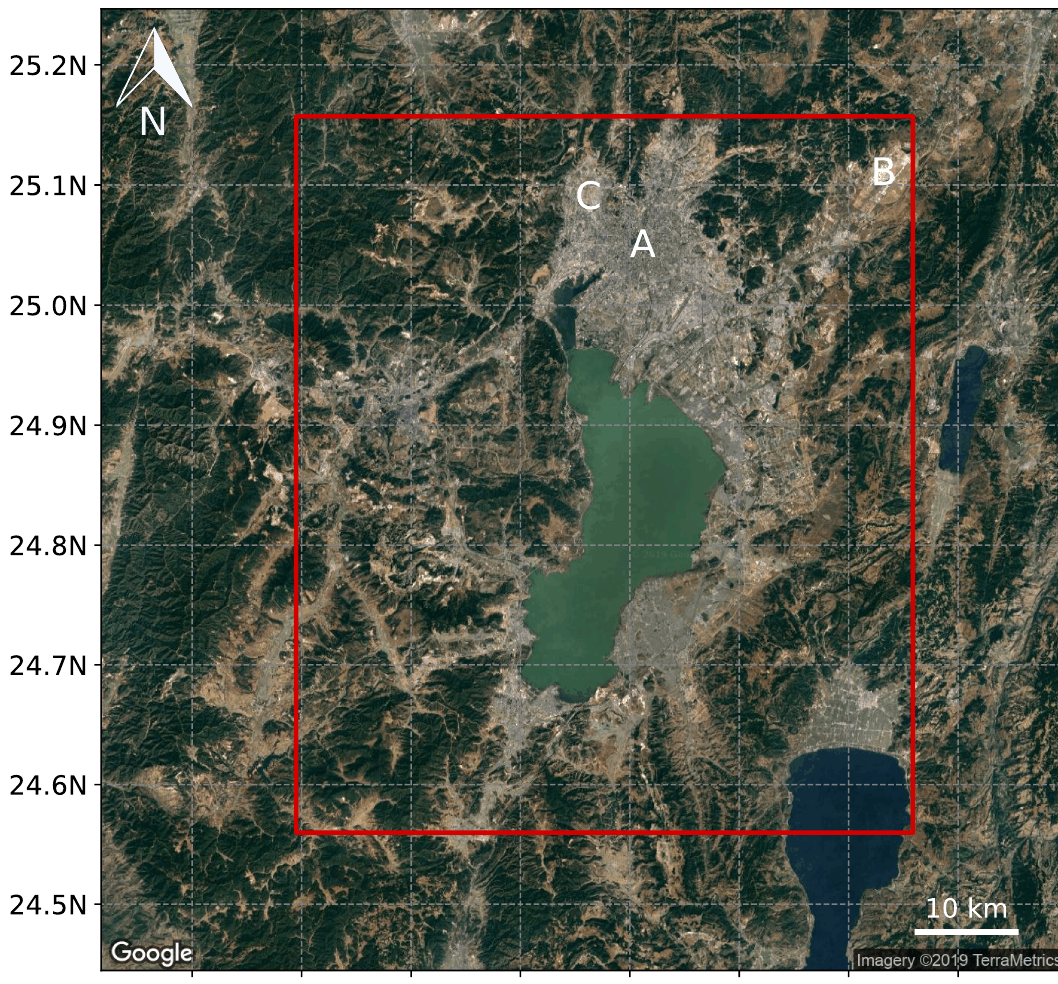
Figure 1. Larger Kunming area, with the Local Climate Zone (LCZ) region of interest in red. A, B, and C are respectively the centre, airport, and high-tech industrial development zone,